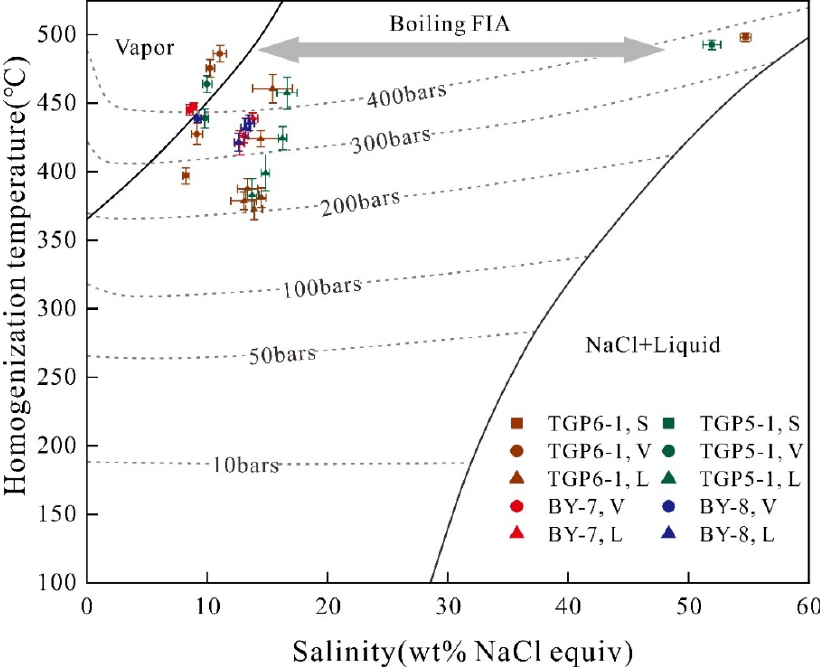
Figure 7. Homogenization temperature vs. salinity in the NaCl-H 2 O system for FIAs from porphyry Cu mineralization in the Tonggou deposit. Isobars were calculated using the equations of Driesner and Heinrich [40].